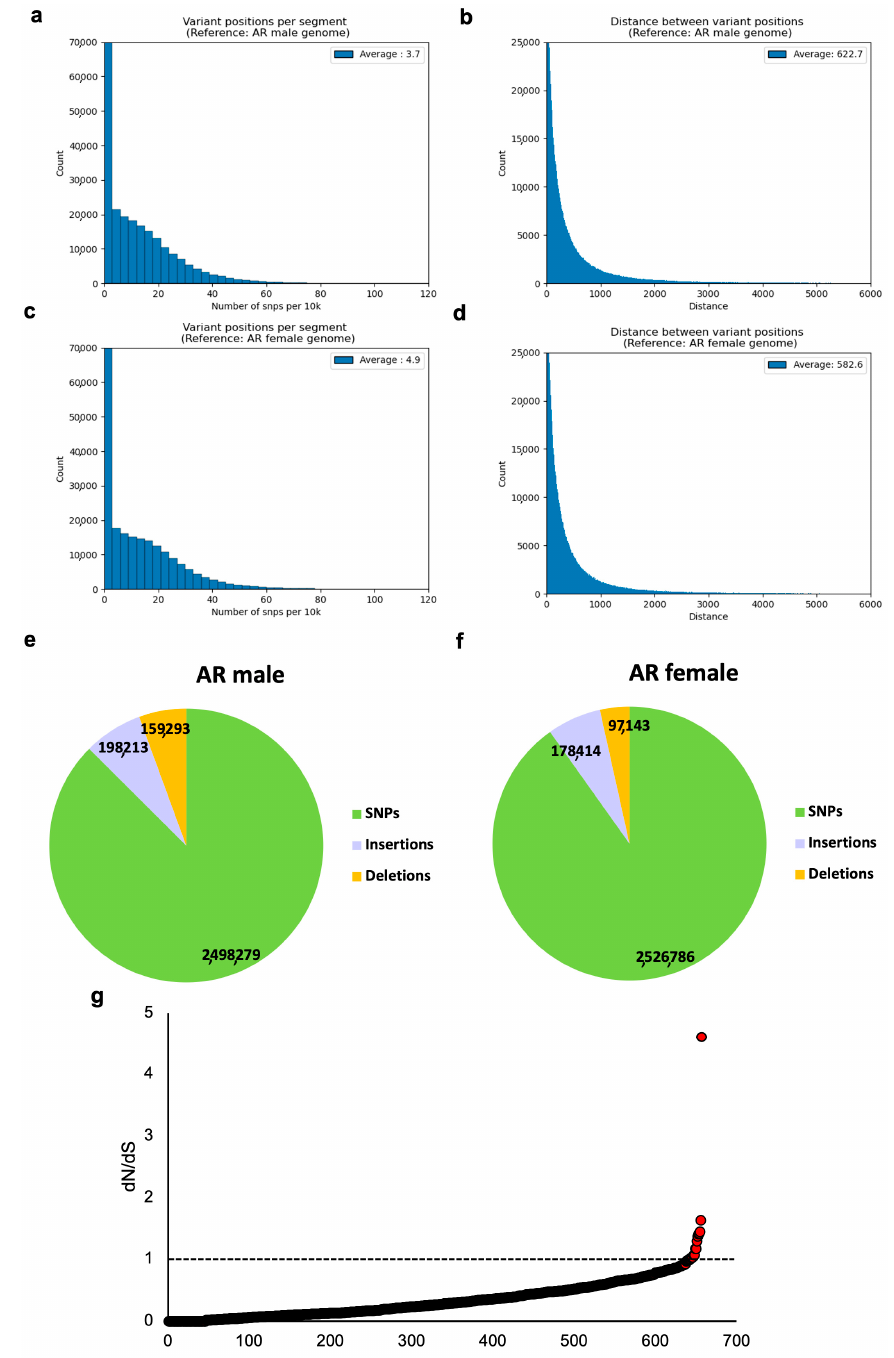
Figure 3. ( a – d ) Distributions of variant positions representing inter-species genomic variation be- tween AG and AR, when mapping to AR male or AR female reference genome: ( a ) variant positions per 10 kb segment, AR male; ( b ) distance between variant positions, AR male; ( c ) variant positions per 10 kb segment, AR female; ( d ) distance between variant positions, AR female. In ( a , c ), average considers all segments, including segments with no variations. ( e , f ) Pie chart representing the contri- bution of different types of variants (SNPs, insertions, and deletions) to the overall variation observed when mapped to ( e ) male and ( f ) female AR genomes. ( g ) dN/dS nucleotide substitution ratios for 657 genes identified in the AG assembly, relative to AR. Note the outlier gene, pdrg1 . Dashed line indicates dN/dS = 1, or neutral selection.